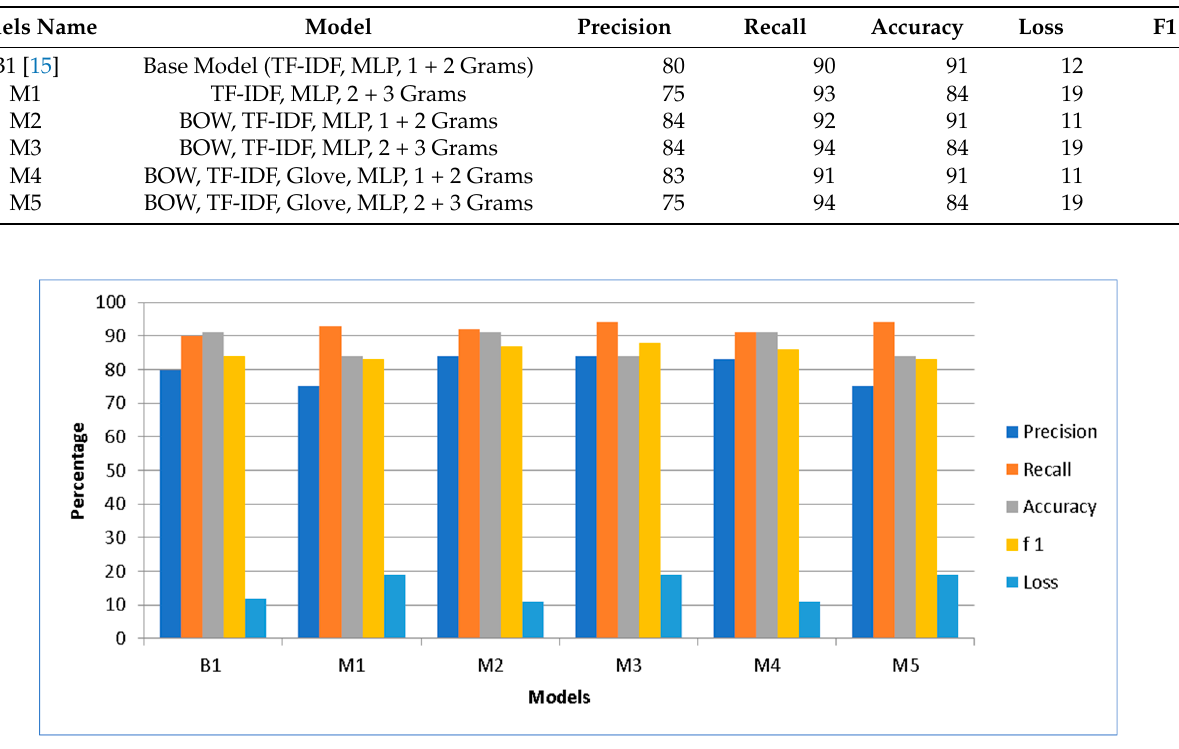
Figure 15. Sadiq, S (2021) Model vs. Proposed Models.